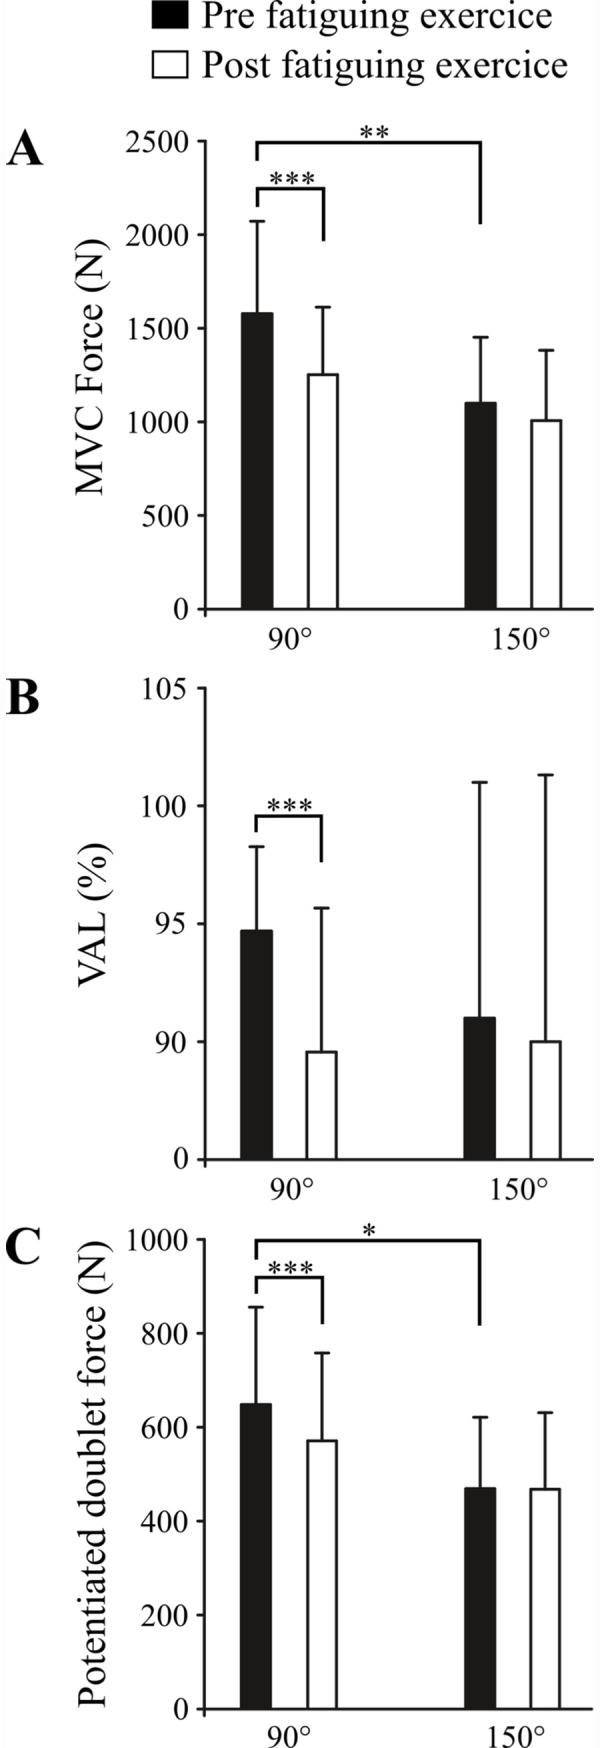
Effect of knee angle and fatiguing exercise on neuromuscular characteristics.A represents the effect of knee angle and fatiguing exercise on MVC force. B represents the effect of knee angle and fatiguing exercise on voluntary activation level, C represents the effect of knee angle and fatiguing exercise on potentiated doublet force. Note that this figure represents the significant interaction between angle and time, i.e. the conditions with vibration and without vibration are pooled. MVC: Maximal voluntary contraction; VAL: Voluntary activation level. * P <0.05, **P<0.01, ***P<0.001.